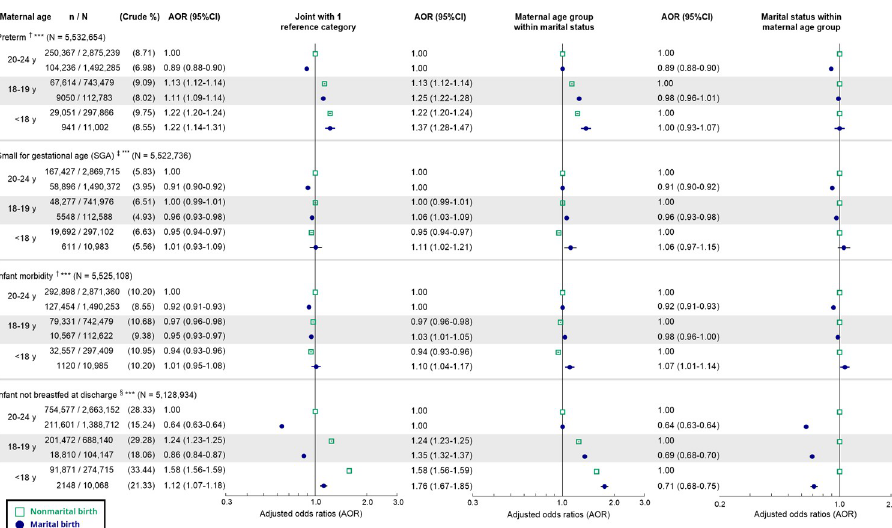
Fig 3. Adjusted odds ratios of infant health indicators associated with the interaction between marital status and maternal age group. AOR plotted on the logarithmic scale. † Adjusted for infant sex, maternal race/ethnicity, maternal US-born status, parity, maternal smoking, prenatal care adequacy, any diabetes (preexisting or gestational), preexisting hypertension, paternal age, WIC benefits received, Medicaid as main payor of the delivery, and birth year. ‡ Adjusted for maternal race/ethnicity, maternal US-born status, parity, maternal smoking, prenatal care adequacy, any diabetes (preexisting or gestational), preexisting hypertension, paternal age, WIC benefits received, Medicaid as main payor of the delivery, and birth year. § Adjusted for maternal race/ethnicity, maternal US-born status, parity, maternal smoking, prenatal care adequacy, paternal age, WIC benefits received, Medicaid as main payor of the delivery, and birth year. ��� p < 0.001 for interaction term between marital status and maternal age. AOR, adjusted odds ratio; WIC, Special Supplemental Nutrition Program for Women, Infants, and Children.